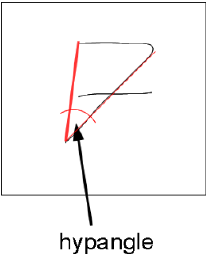
Figure 6. Representation of the parameter “HYP_ANGLE”.